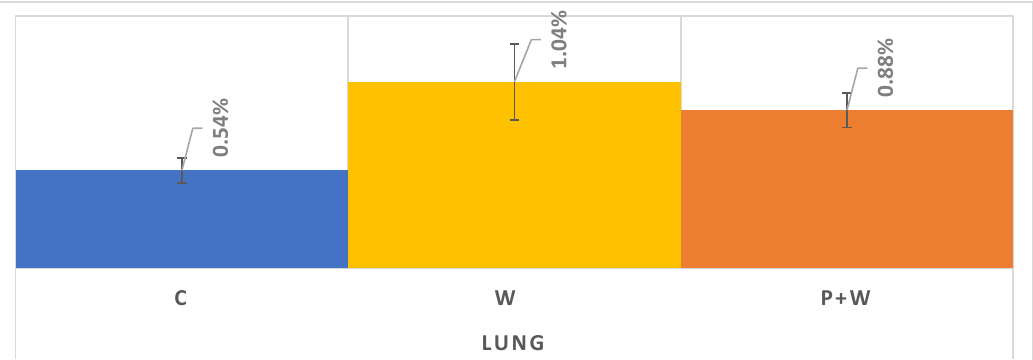
Figure 6. Lung cancer screening during 1-year follow up in selected 20 counties with access to LDCT .